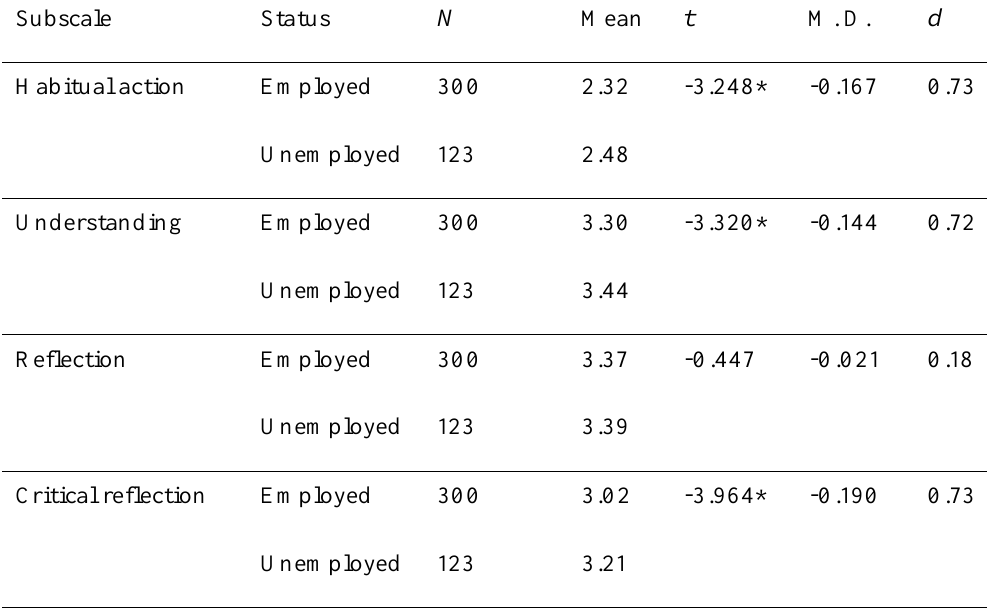
Table 6 Impact of AIOU Students’ Employment Status on their Thinking Patterns